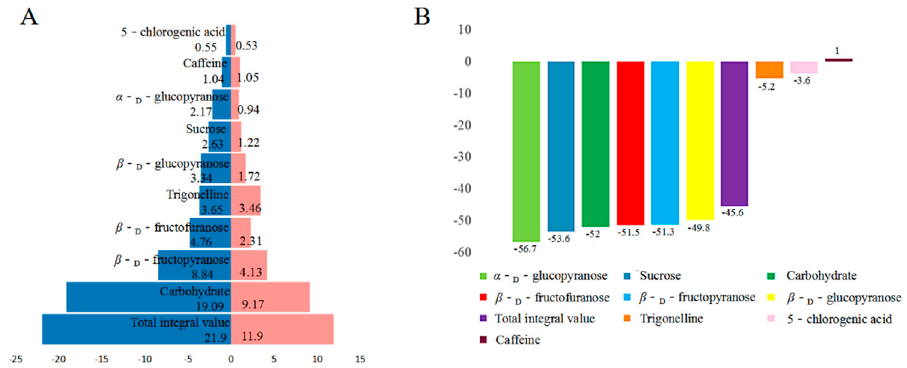
Figure 4. ( A ) the relative integral area of different compounds before (blue) and after roasting (pink); ( B ) the change rate of different compounds after roasting.